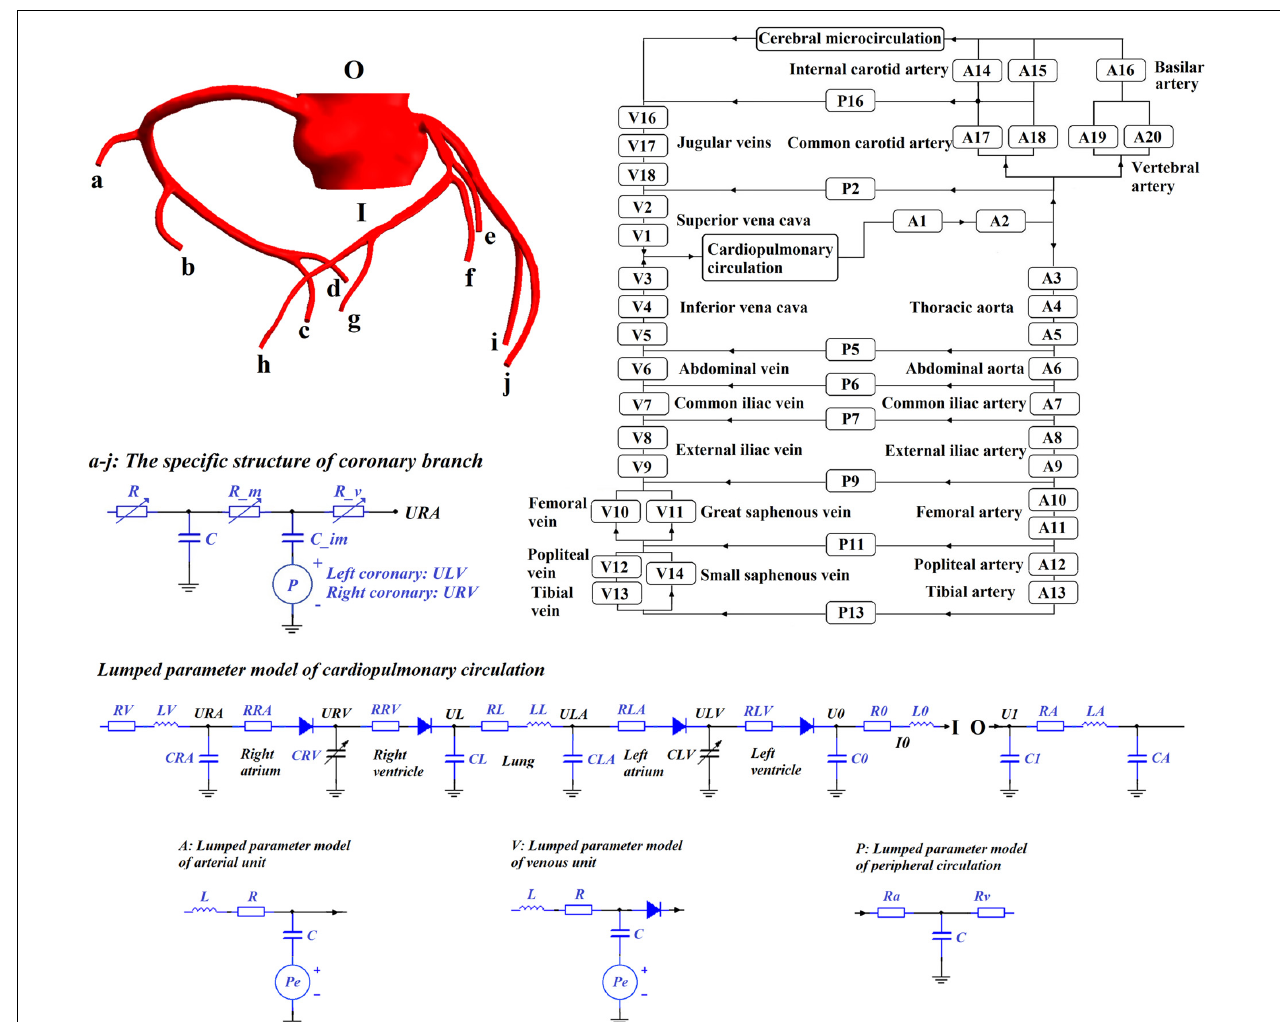
FIGURE 1 | Universal 0D/3D geometric multi-scale standard model of a coronary